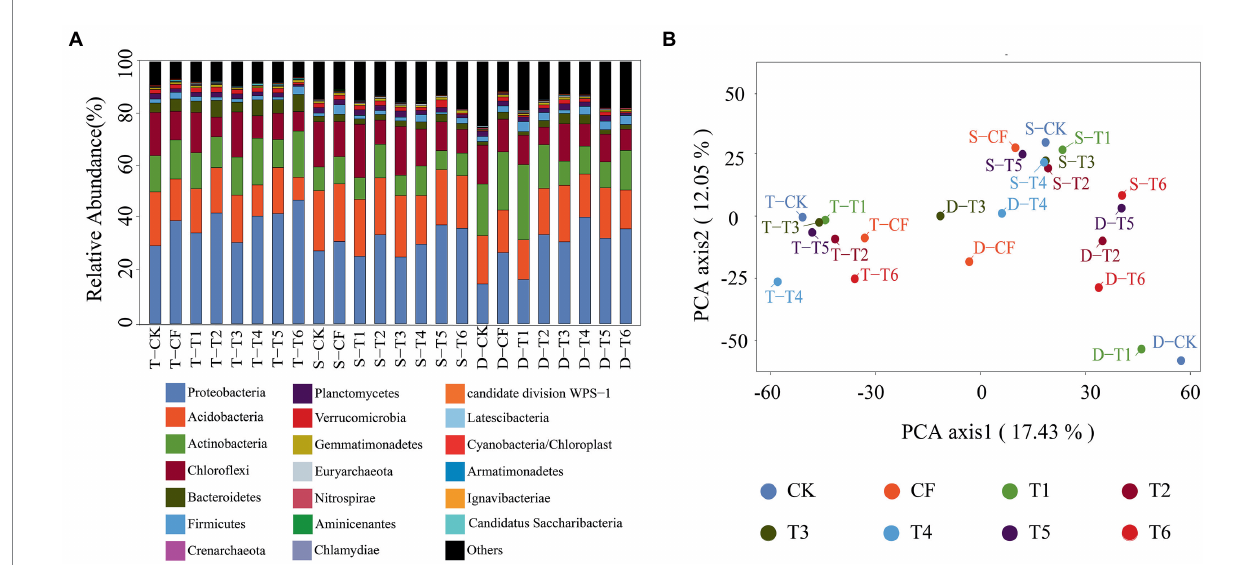
FIGURE 4 Distribution characteristics of soil microbial community under different fertilization modes, (A) showing the abundance of microbial community at each site across different soil layers; (B) showing PCA analysis of microbial communities. T. 0–20 cm in the topsoil; S. 20–50 cm in the subsoil, D. 50– 80 cm in the deepsoil. Fertilization treatment abbreviation is shown in Figure